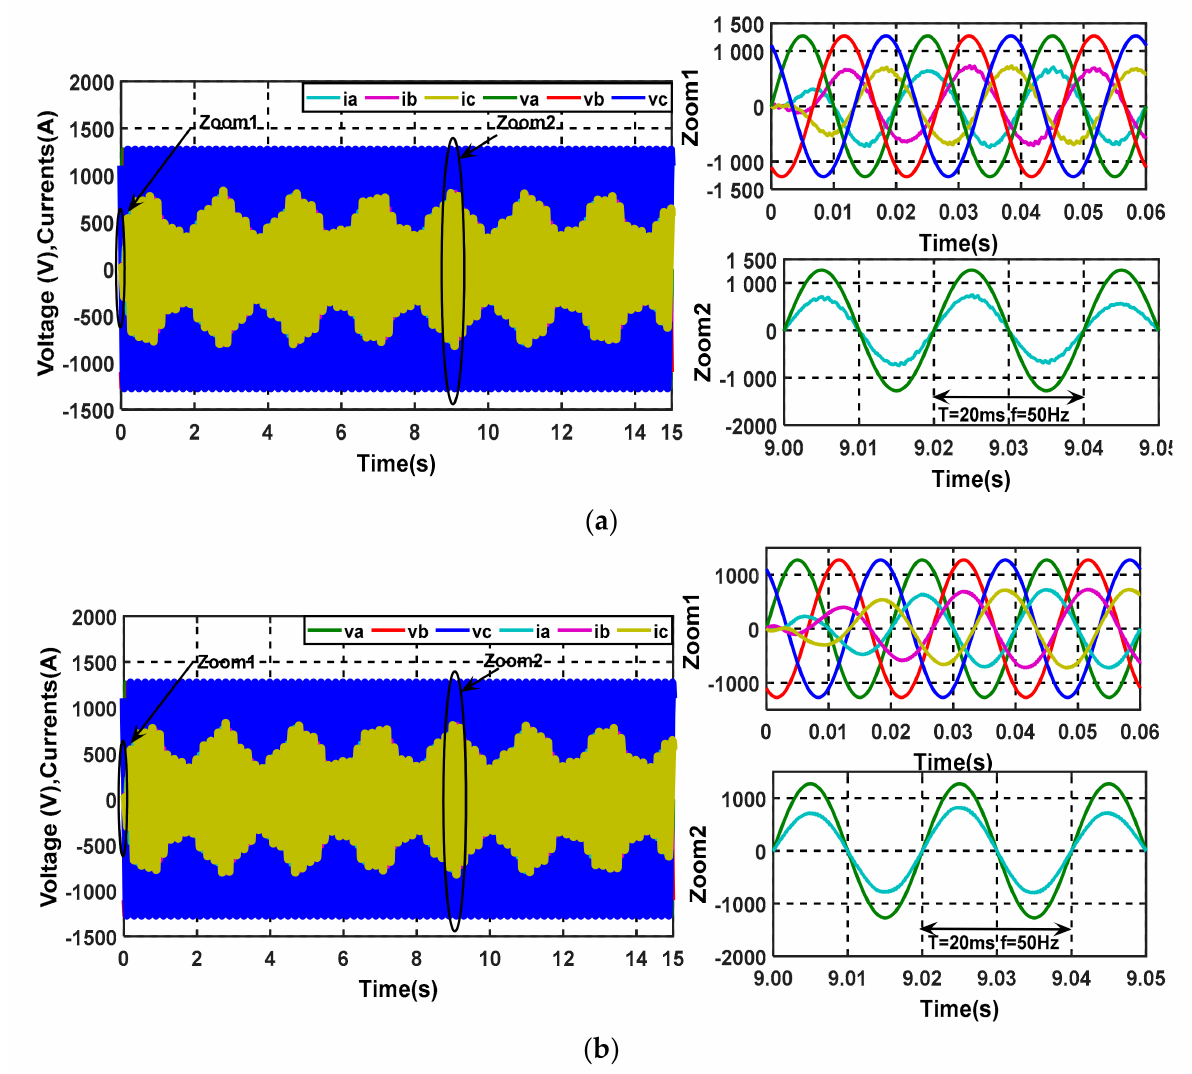
Figure 10. Grid voltage and injected current: ( a ) using the CSMC strategy and ( b ) using the PSMC